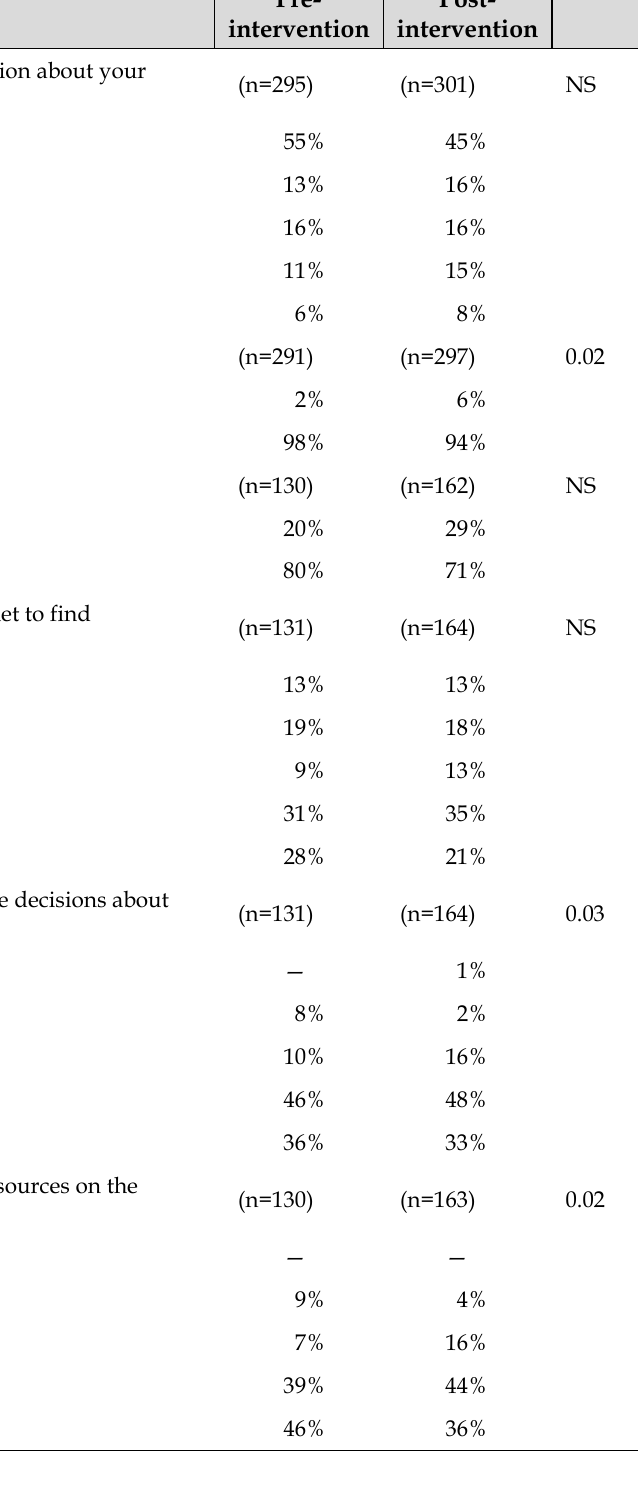
Pre- Post- intervention